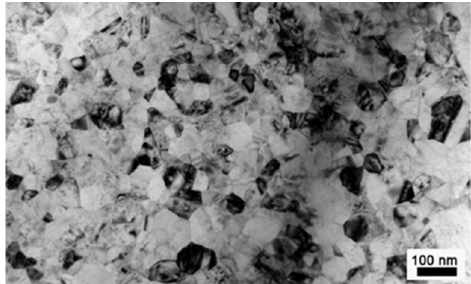
Figure 4. A TEM illustration of the nanocrystalline Copper.